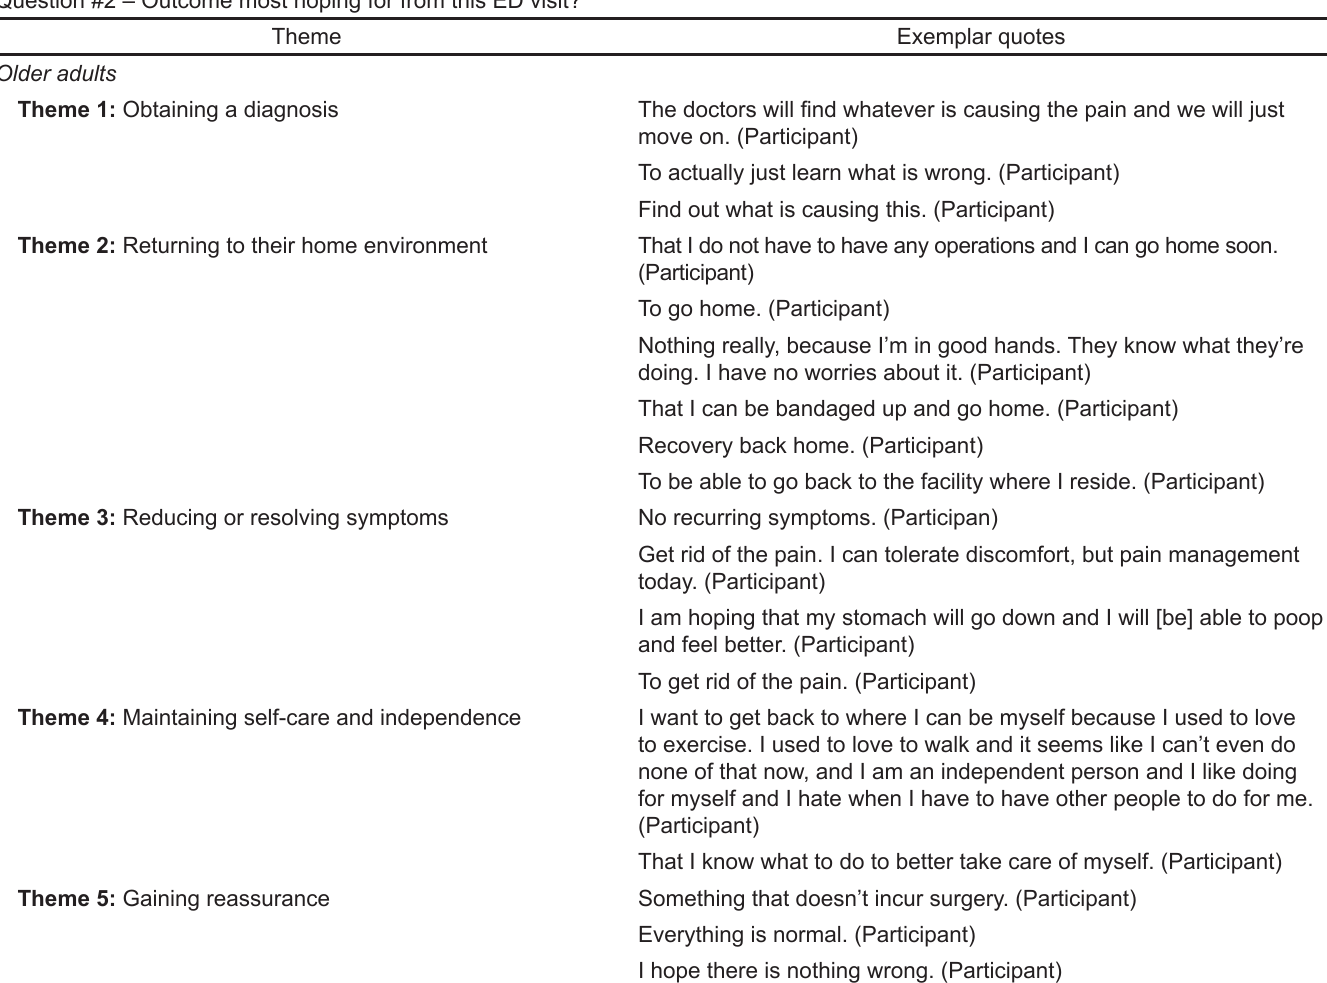
Table 4. Desired outcomes related to emergency care of older adults and their treating clinicians. Question #2 – Outcome most hoping for from this ED